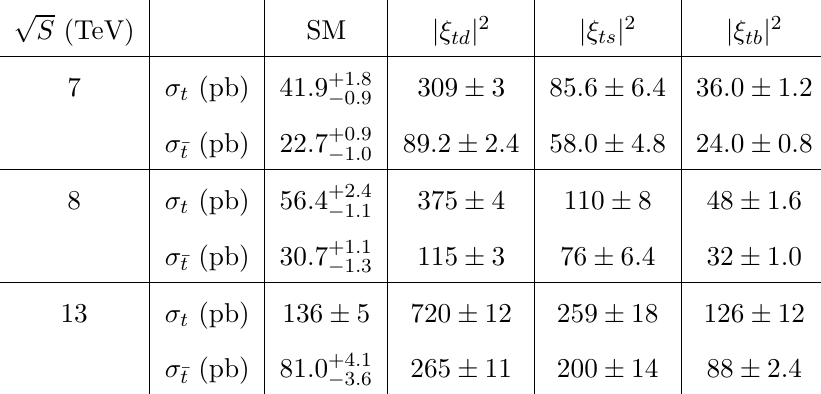
Table 4 . t -channel single-top cross section in the presence of (cid:24) tj